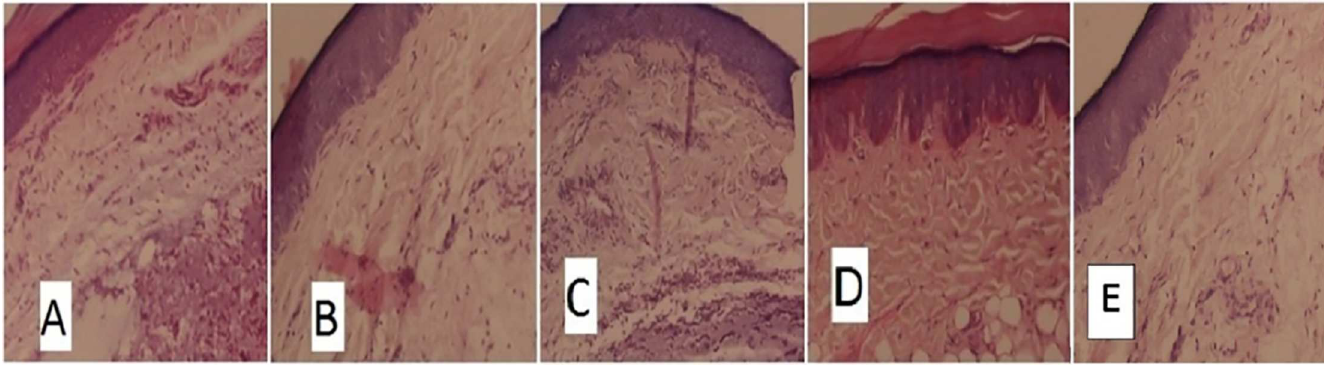
Fig 2. Histological examination of paw sections after 3 h of carrageenan injection. (A) Control group (Normal saline 1ml/kg), (B) Acetylsalicylic acid group(100mg/kg), (C) Ethylacetatefraction group (500mg/kg), (D) MethanolExtract group (500mg/kg), (E) Active Compound4 group